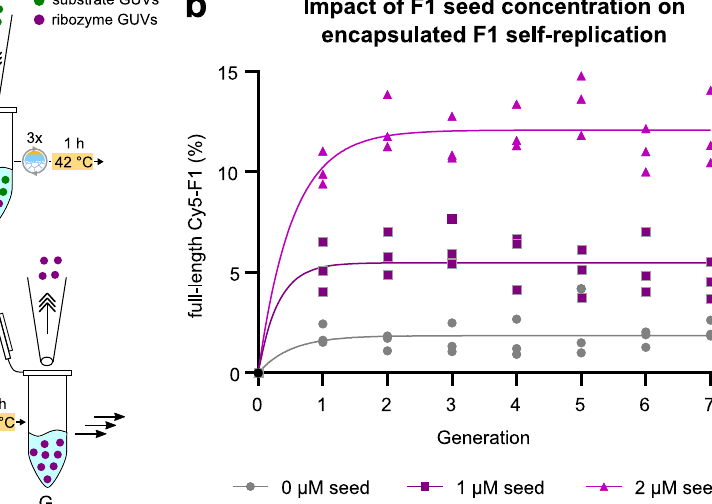
Fig.3|Serialdilutionofencapsulatedself-replicatingF1.a Experimentalsetupof theserialdilutionexperimentbasedonthevesiclesetupdepictedinFig.2a.Brie fl y, after each cycle of ampli fi cation consisting of three successive freeze-thaw (FT) cyclesfollowedbya1-hincubationperiodat42°C,halfofthevolumewasreplaced with fresh substrate vesicles and the entire process was repeated. Only G 0 /G 1 contained a speci fi c seedconcentration ofunlabelled full-length F1. No exogenous full-length ribozyme was added in later generations. b Ligation yields of Cy5- labelled F1 after each generation. GUVs containing either 0 µ M (grey circles), 1 µ M